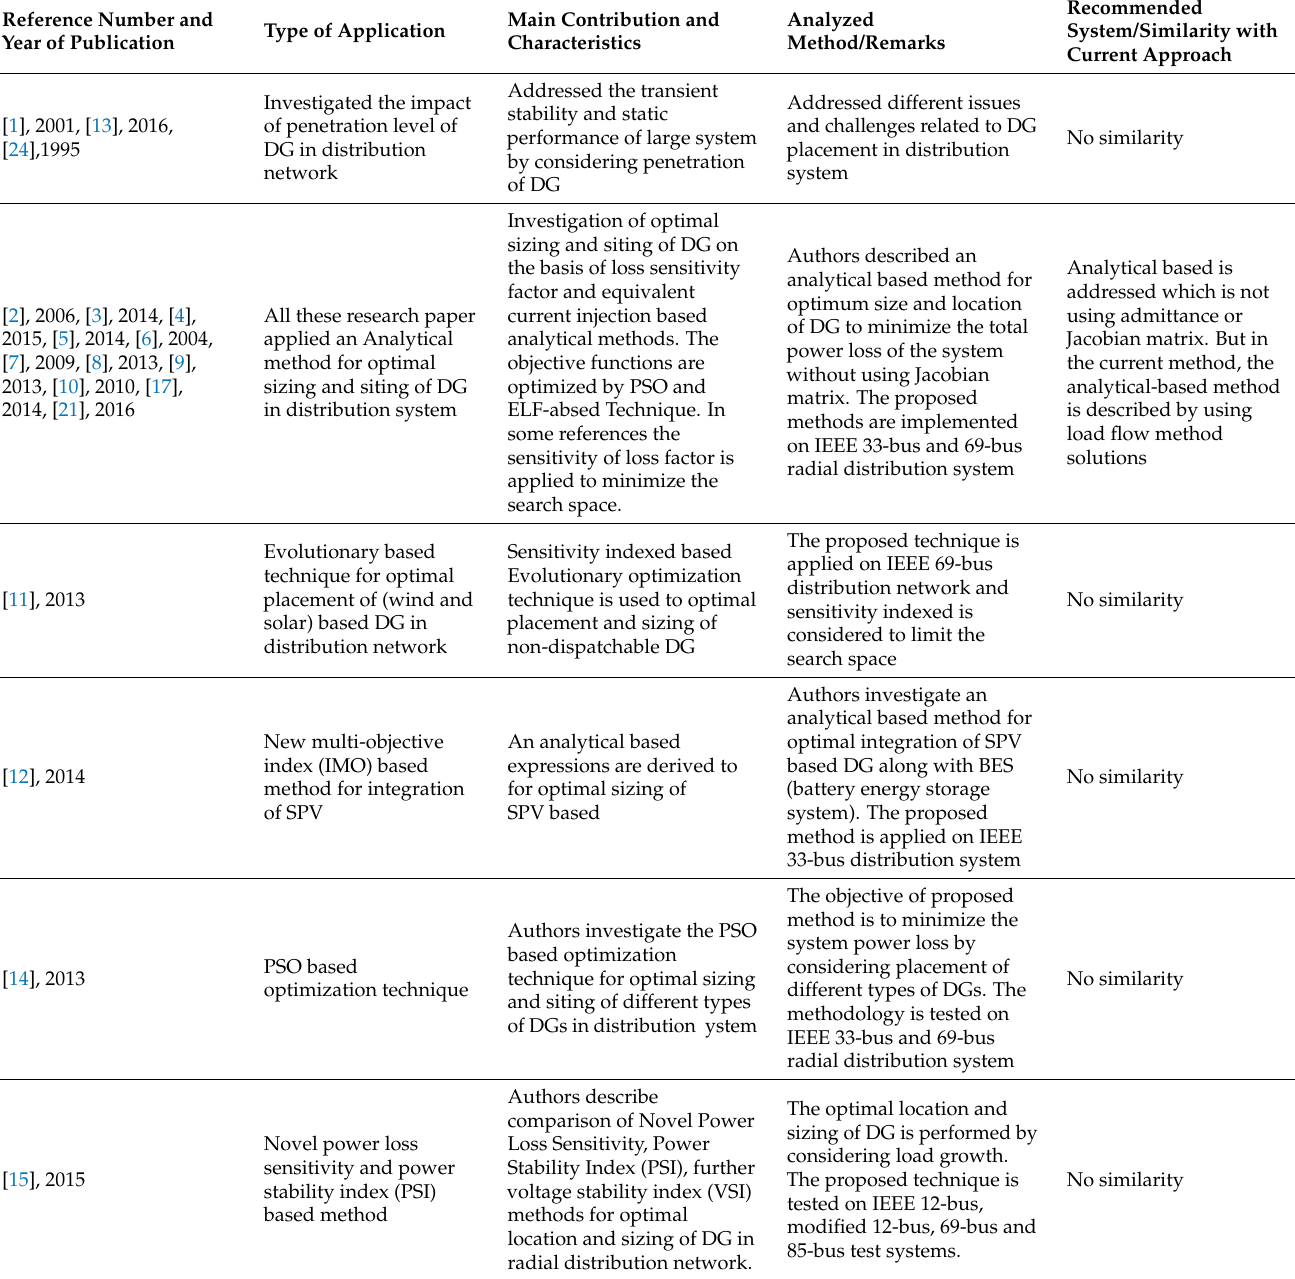
Table A1. Summary of the related